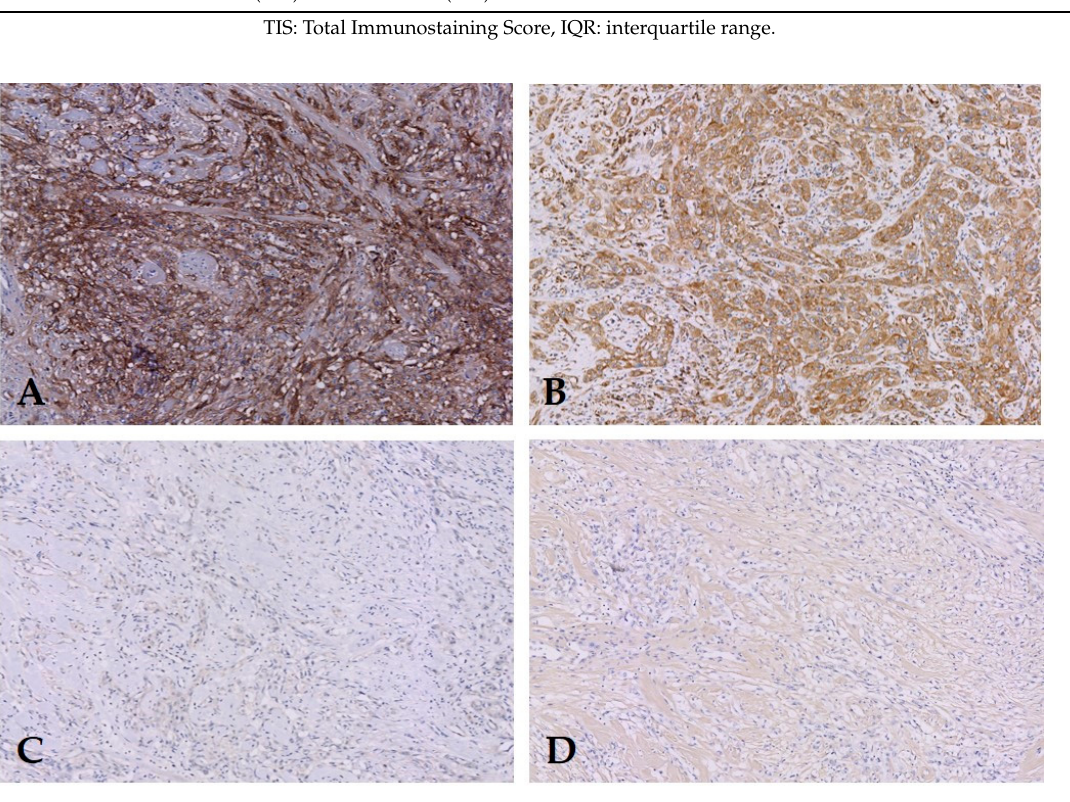
Figure 1. Primary tumor of one patient with ( A ) EGFR and ( B ) VEGF expression but absence of ( C ) prostate-specific membrane antigen (PSMA) and ( D) EpCAM expression. Original magnification 200×.